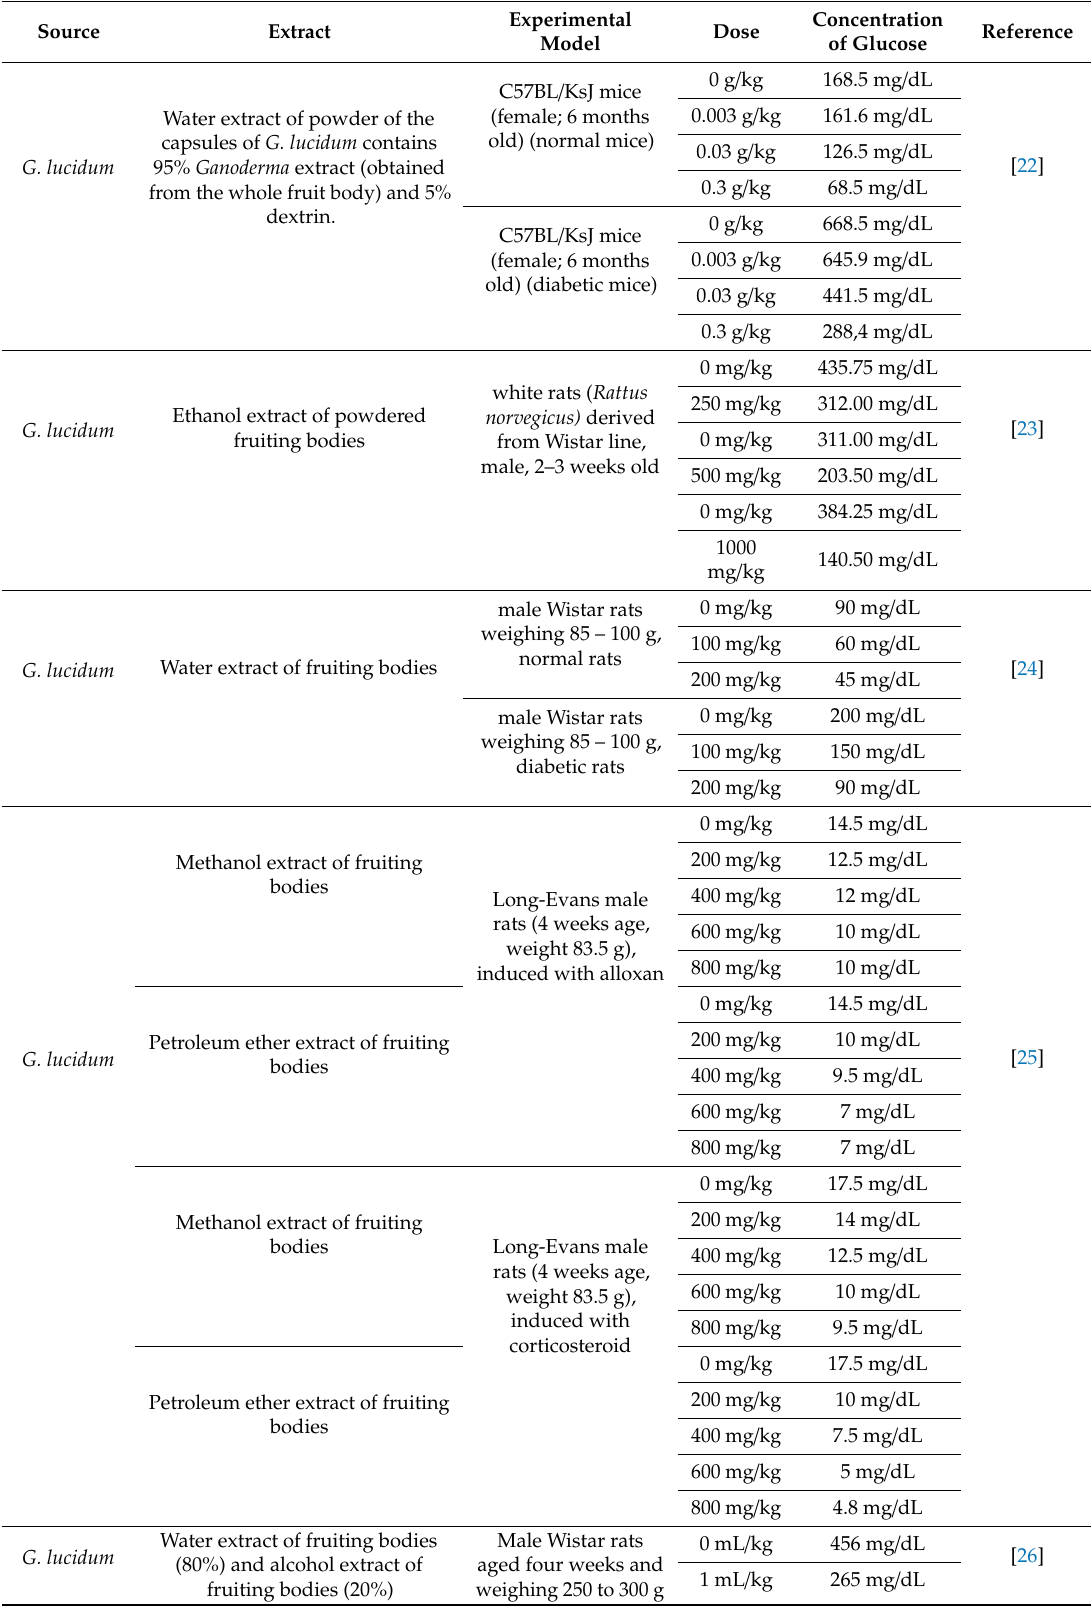
Table 1. Research activity of extracts of Ganoderma in animal models of